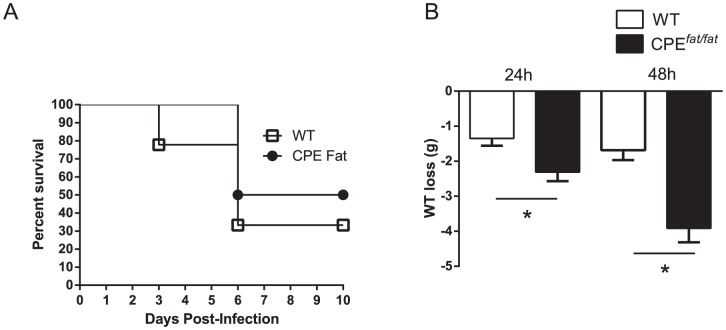
Survival of WT and CPEfat/fat mice following S. pneumoniae infection (A). Body weight loss, expressed as total weight loss, 24 and 48 h post-infection (B).Mice were infected with 5×104 CFUs of S. pneumonia via the intratracheal route and monitored for survival for 10 days. N = 6–9 mice per group from 2 independent experiments. Survival was evaluated using the log-rank test. *, p<0.05, total weight loss for WT vs CPEfat/fat mice post-infection using a student's t-test, n = 5 (24 h) and 15 (48 h) mice per group.